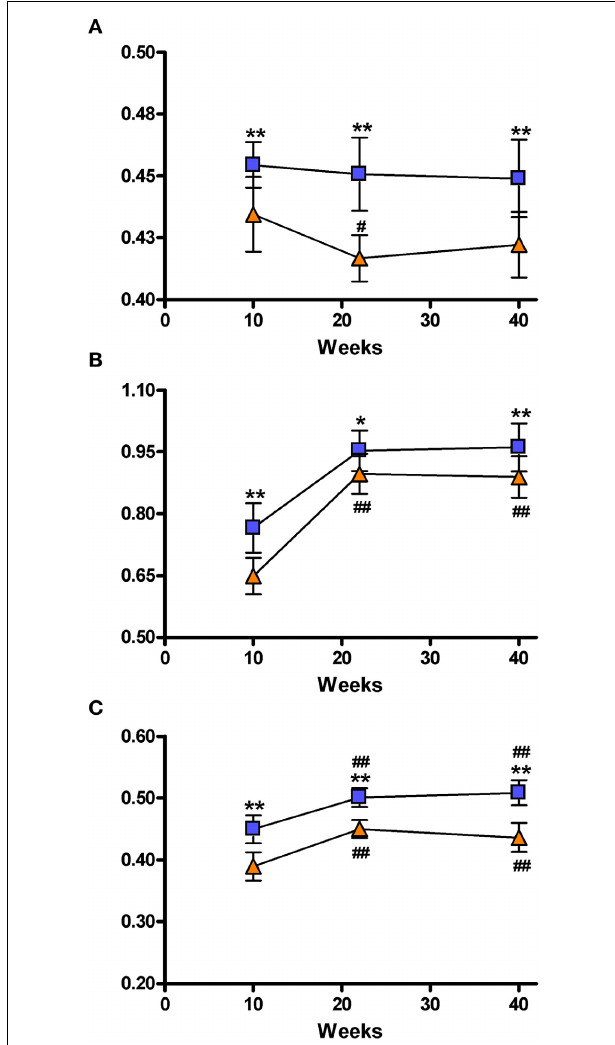
FIGURE 5 | Representation of the brain network connectivity. Network connectivity indices at 10, 22, and 40 weeks. (A) Hierarchical modularity; (B) Global Efficiency; (C) Local efficiency. The blue squares represents the control animals and the orange triangles the SHRs. Data is represented as mean ± s.e.m. Asterisks indicate differences between groups (Bonferroni test) ∗ P < 0 . 05, ∗∗ P < 0 . 01. Hash tags indicate differences to 10 weeks (Bonferroni test) # P < 0 . 05, ## P < 0 . 01.